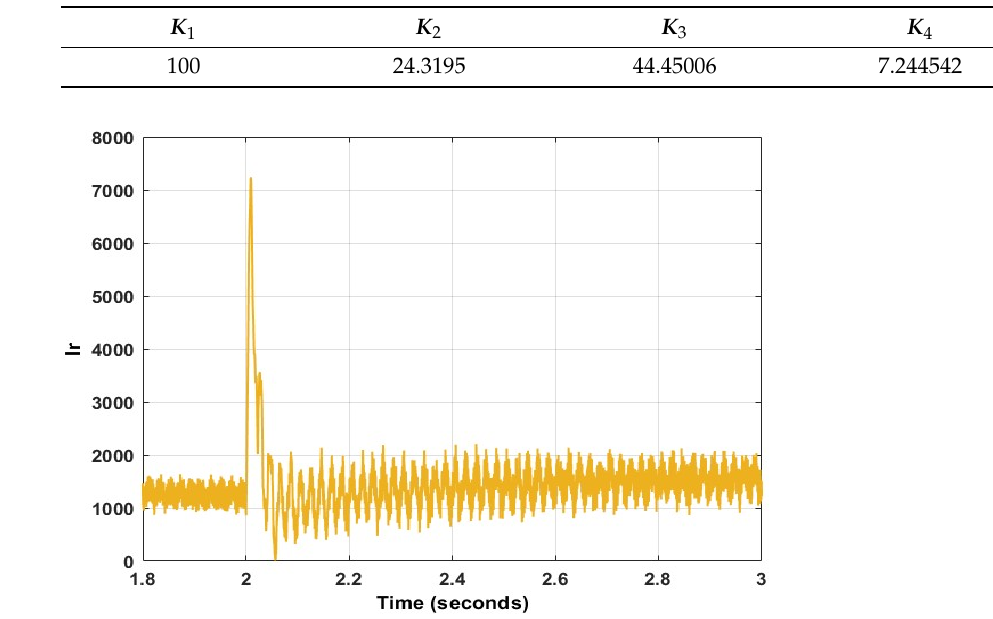
Figure 53. Rotor current transient using LQR at 90% dip.